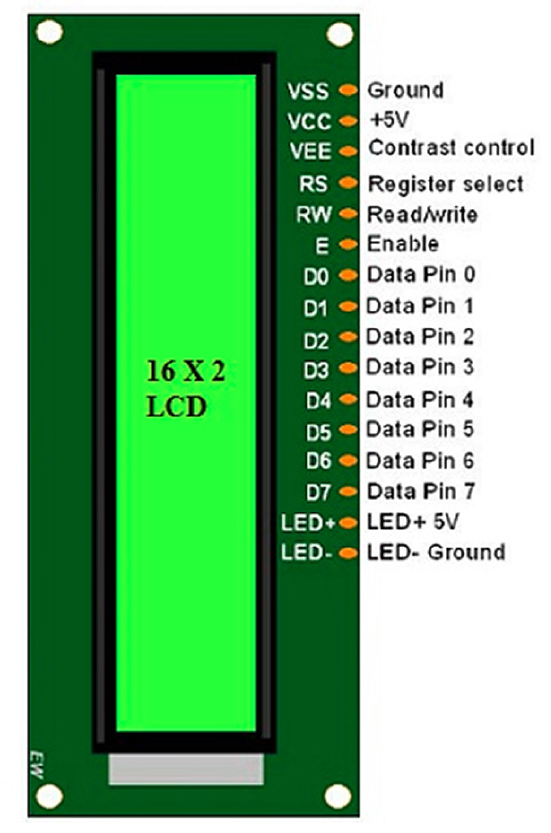
Fig. 10. Component parts of LCD 16X2